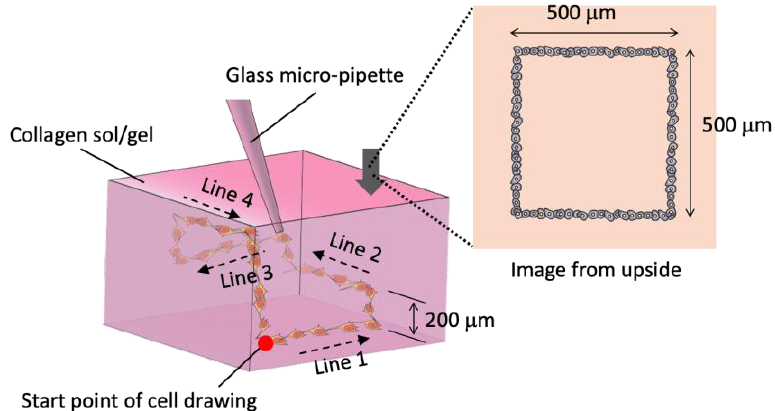
Figure 3. Square pattern drawing of PC-12 cells with four sides of different depth.